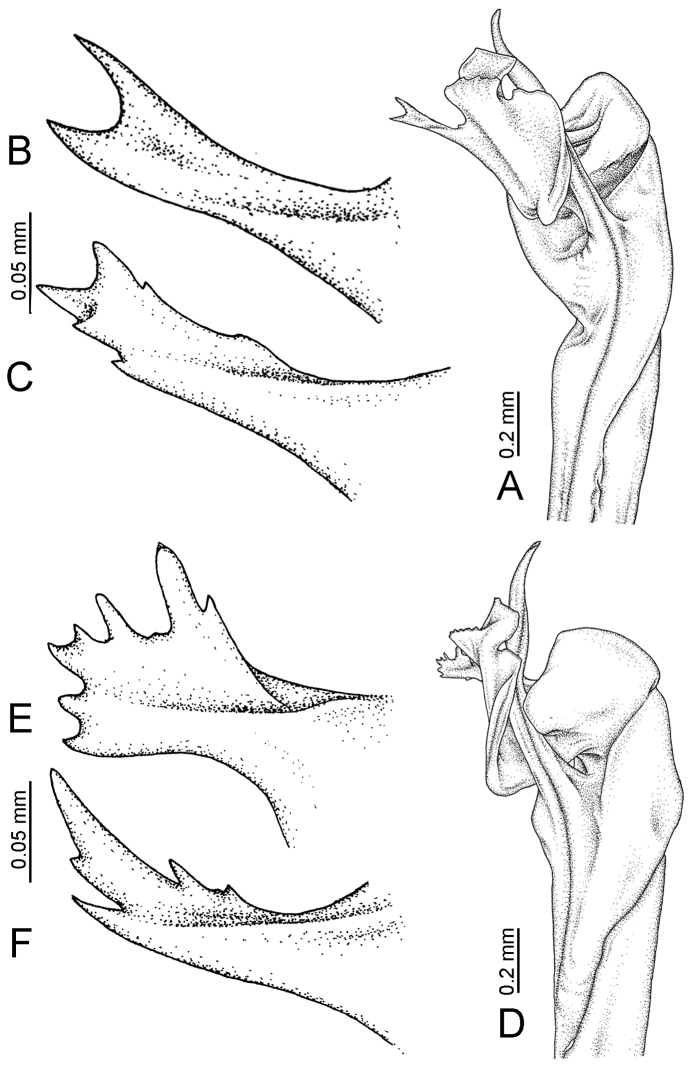

Desmoxytes
purpurosea Enghoff et al., 2007 – right gonopod. A mesal view (specimen from Hup Pa Tard) B, C process (plm) of lamina medialis (Lamphun and Uthai Thani populations) D dorsal view (specimen from Tham Than Lod cave) E, F process (plm) of lamina medialis (Kanchababuri A and B populations).